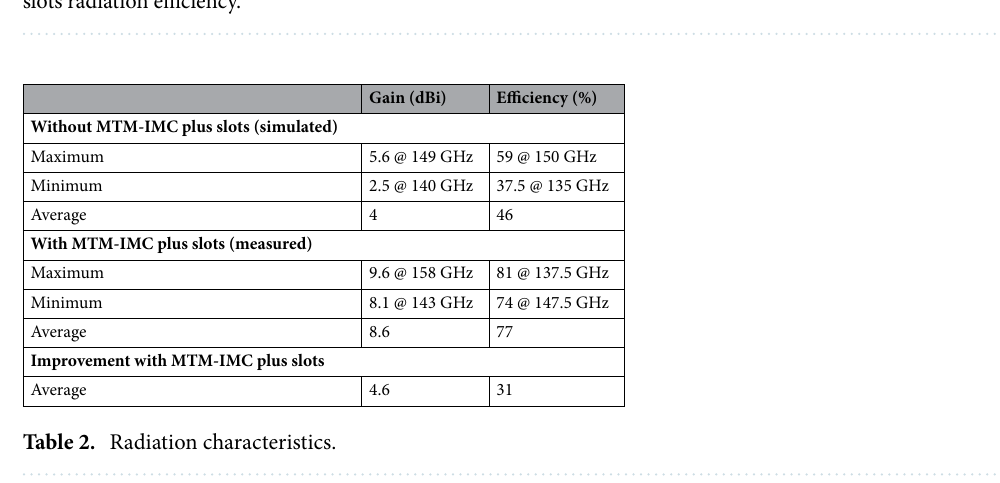
is attenuated at its sides. These results show that changes in frequency does not cause significant changes in the radiation patterns. Also, there is good correlation between the simulated and measured results.